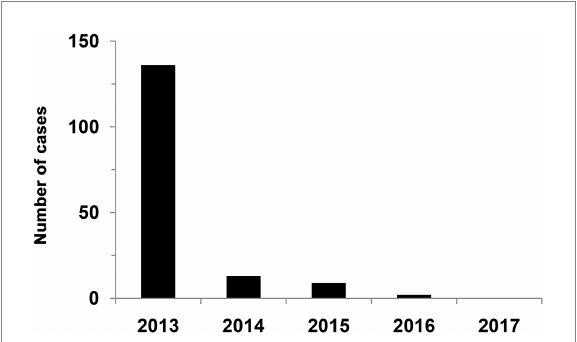
FIGURE 8 Rabies incidence in reindeer in post-vaccination period. The data were taken from the official annual report on the epizootological situation with extra dangerous diseases in Russia in